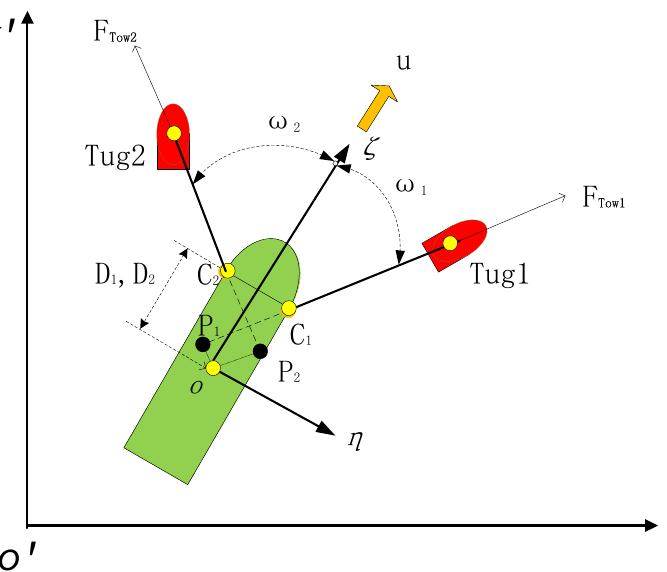
Figure 2. Analysis diagram of the motion force of the longitudinal operation.